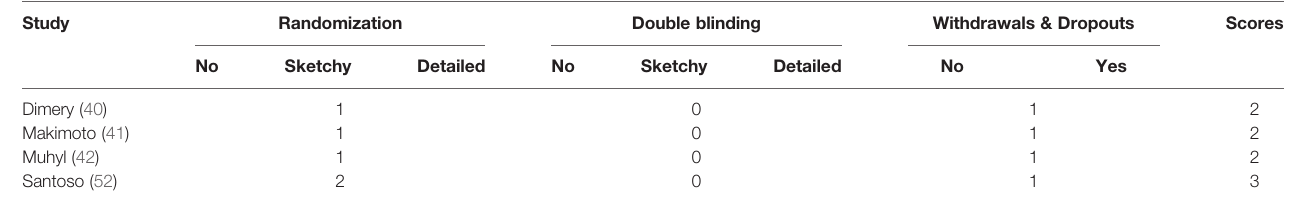
TABLE 2 | Results of quality assessment using the Jadad Score (5-points) for RCTs.